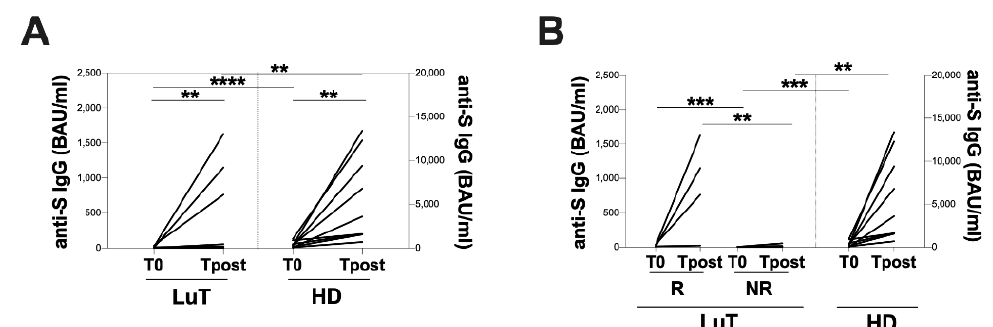
Figure 2. Evaluation of vaccination-induced humoral response. ( A ) Anti-S IgG titer was evaluated in the LuT and HD groups at T0 and at Tpost. Longitudinal evaluation was performed using Wilcoxon test. For each time-point, differences between LuT and HD were evaluated using the nonparametric Mann–Whitney test. ( B ) Stratification of LuT patients into R and NR, according to the anti-S IgG titer at T0. Longitudinal evaluation was performed using Wilcoxon test. Each group of LuT patients was compared to the respective HD time-points using the nonparametric Kruskal–Wallis’s test with Dunn’s post-test. T0: before the third dose of vaccine; Tpost: two months after the third dose; LuT: lung transplants; HD: healthy donors; R: responders; NR: non-responders; BAU: binding antibody unit. ****: p < 0.0001; ***: 0.0001 < p < 0.001; **: 0.001 < p < 0.01. At T0, 88.9% (8/9) of LuT patients had a serologic response against SARS-CoV-2 under the cut-off value of 33.8 BAU/mL, according to the manufacturer’s instructions. Conversely, at Tpost, 55.6% (5/9) of LuT patients showed a serologic response against SARS-CoV-2 under the cut-off